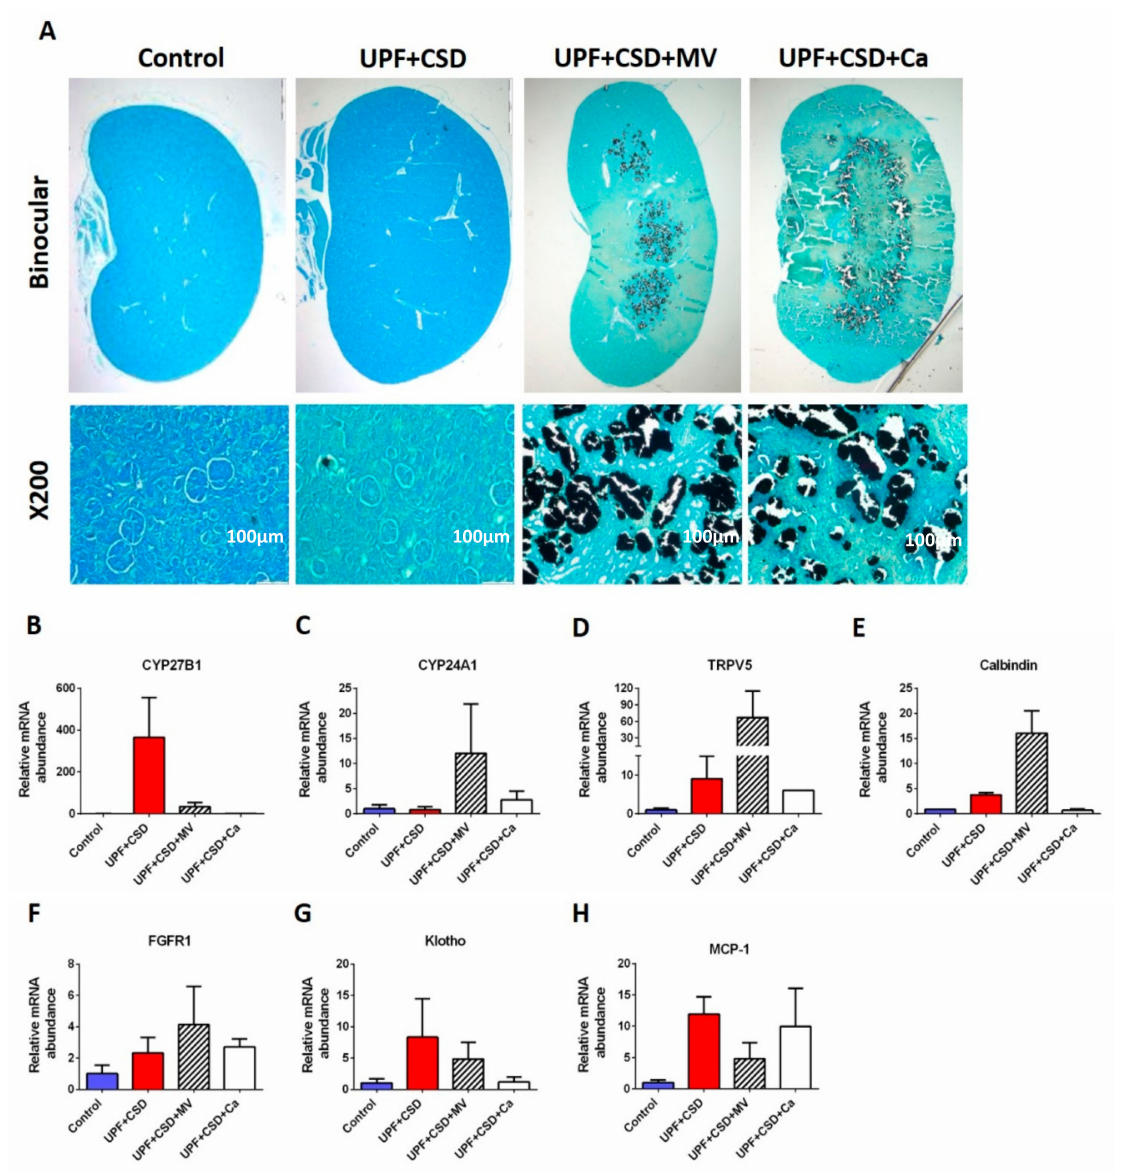
Figure 6. Supplementation of ultra-processed diet results in formation of mineral deposits in the kidneys. ( A ) Kidneys from Control, UPF + CSD, UPF + CSD + MV, and UPF + CSD + Ca